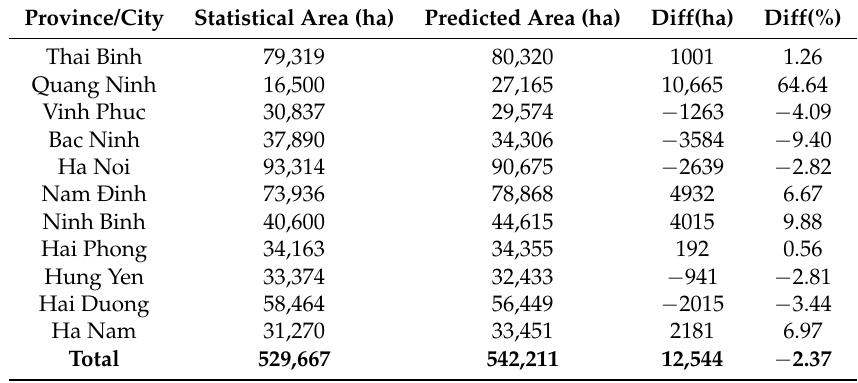
Table 6. A comparison of rice area according to statistics and classification at the provincial